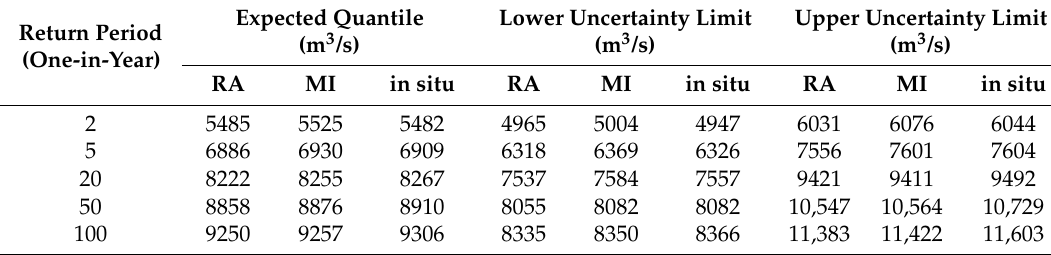
Table 5. Baro flood quantile estimates and uncertainty boundaries for in situ, MI, and RA filled datasets.